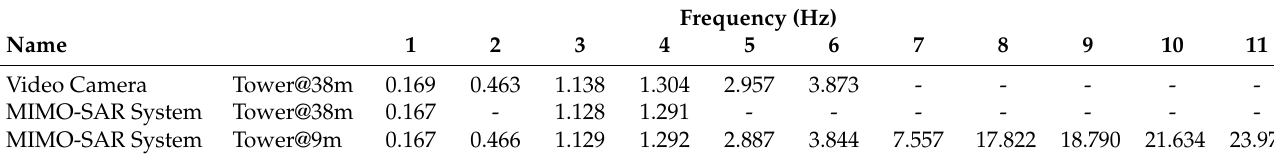
Figure 15. Fourier transform of the tower movement ∆ D derived from MIMO-SAR acquisitions for the frequency range between 0 and 30Hz. Table 3. Deformation frequencies of the wind turbine